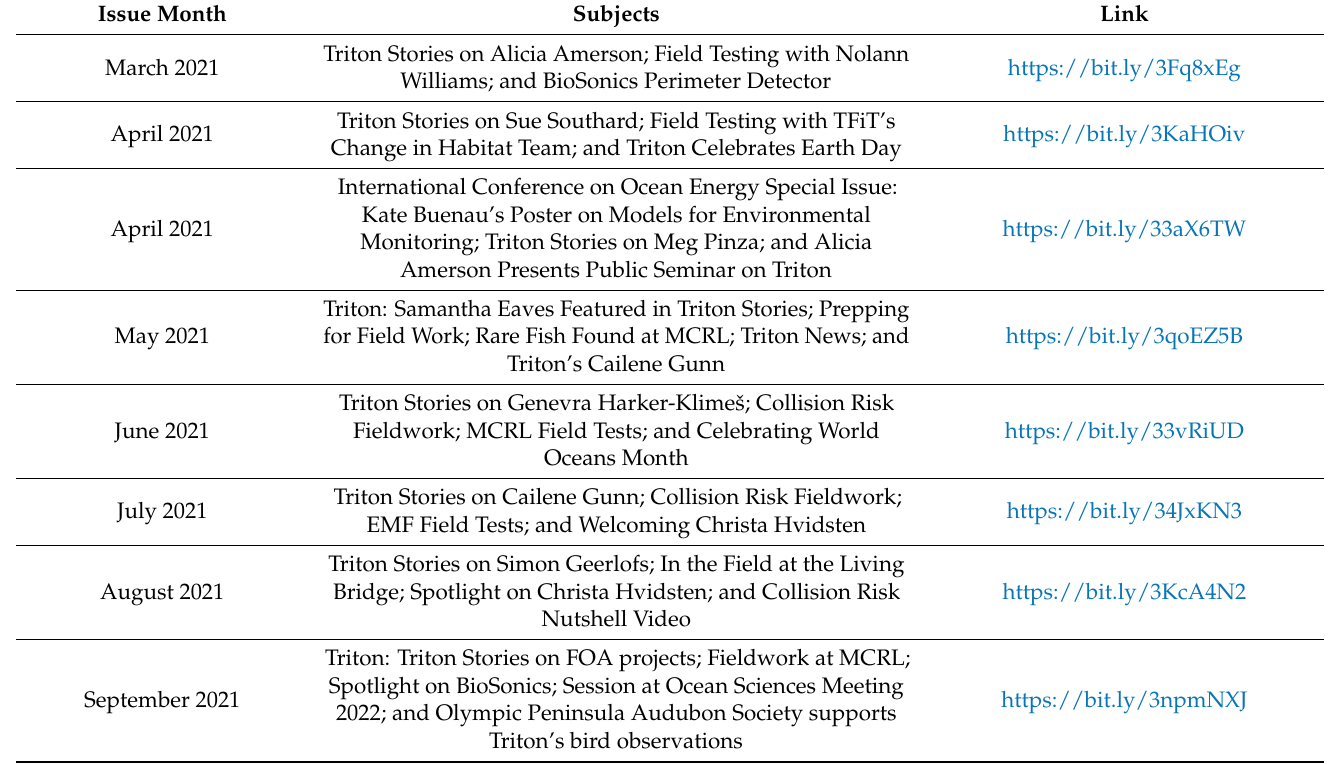
Figure A1. Example of Triton Stories blog publish dates corresponding to spikes in website pageviews from 1 July 2020 to 31 October 2020, including (a) predictive modeling Triton Story, published 31 July 2020, 171 pageviews; (b) research diving Triton Story, published 8 September 2020, 114 pageviews; and (c) changes in habitat research Triton Story, published 7 October 2020, 116 pageviews. Data from Google Analytics. Table A2. Triton newsletter issues published from March 2021—September 2021, including links.